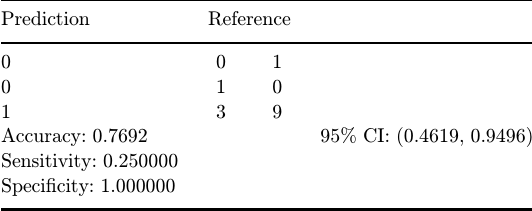
Table 6. Prediction results using logistic